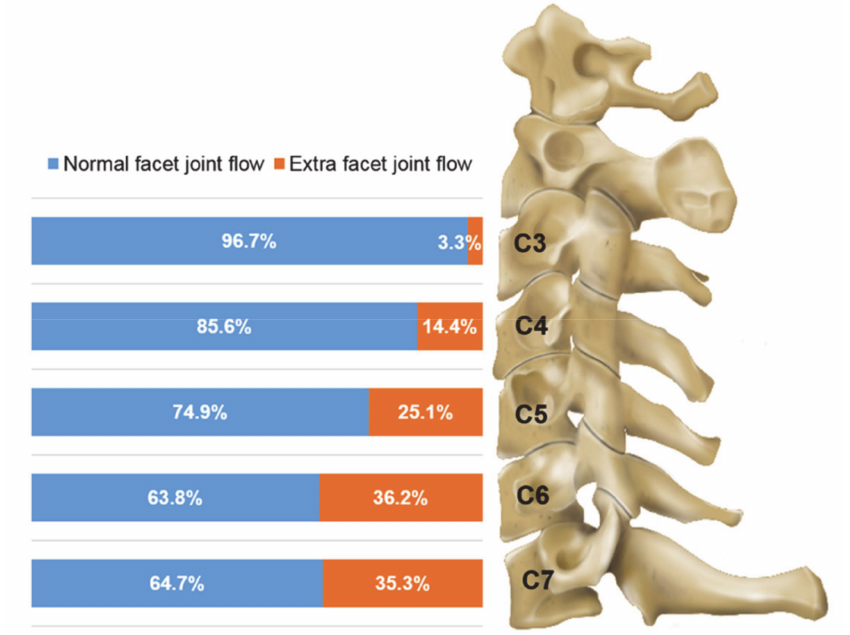
Figure 3. Frequency of extra-cervical facet joint flow at C3–C7 vertebral levels according to age groups and